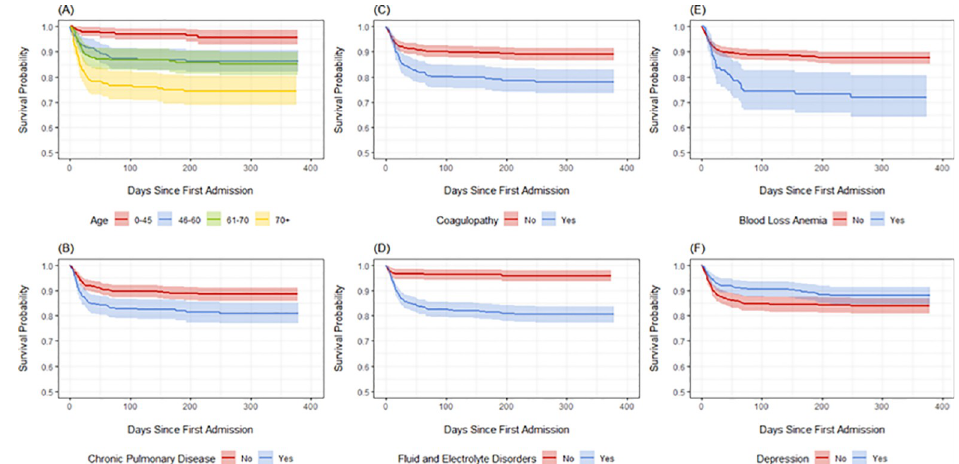
Fig 2. Kaplan-Meier curves for post-admission mortality among hospitalized COVID-19 patients, stratified by (A) age quartiles, (B) chronic pulmonary disease, (C) coagulopathy, (D) fluid and electrolyte disorders, (E) blood loss anemia, and (F)